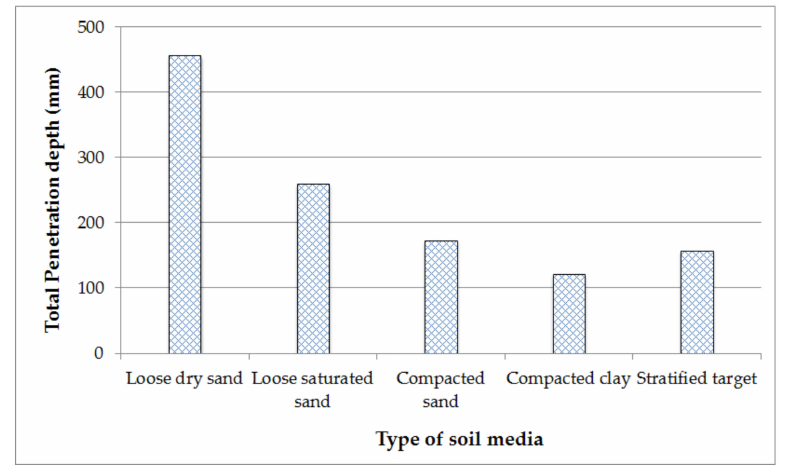
Figure 2. Penetration depth of conical nose projectile in dry, saturated, and compacted soil